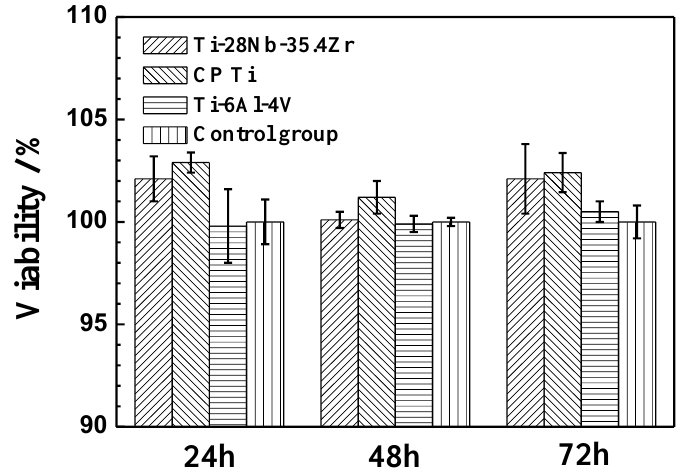
Figure 9. MTT result of MC3T3-E1 cells cultured with extracts of Ti-28Nb-35.4Zr, CP Ti and ELI Ti-6Al-4V.